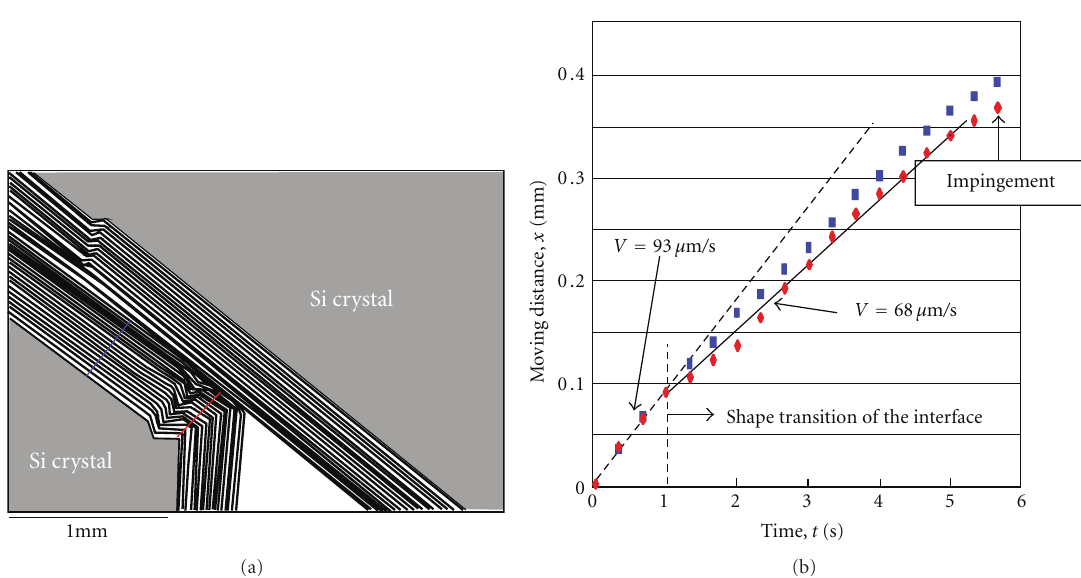
Figure 8: (a) Isochrones of positions of growing interface at 1/3 s intervals for sample shown in Figure 7 [41]. (b) t-x plot of moving interface for two parts shown by red and blue lines across isochrones in (a). The color of dots corresponds to the color of the lines in (a). The moving velocity of the interface is lower from the initiation point of the interface shape transition